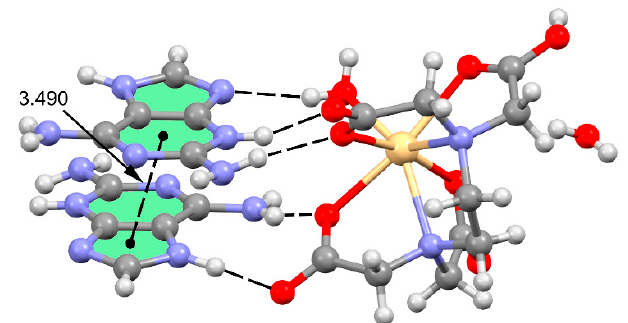
Figure 4. Molecular recognition pattern showing the cooperation of H-bonds and π , π -stacking interactions connecting the [Cd(HEDTA)(H 2 O)] − chelate anion with two of the neighboring H 2 (N3,N7)dap + ions.